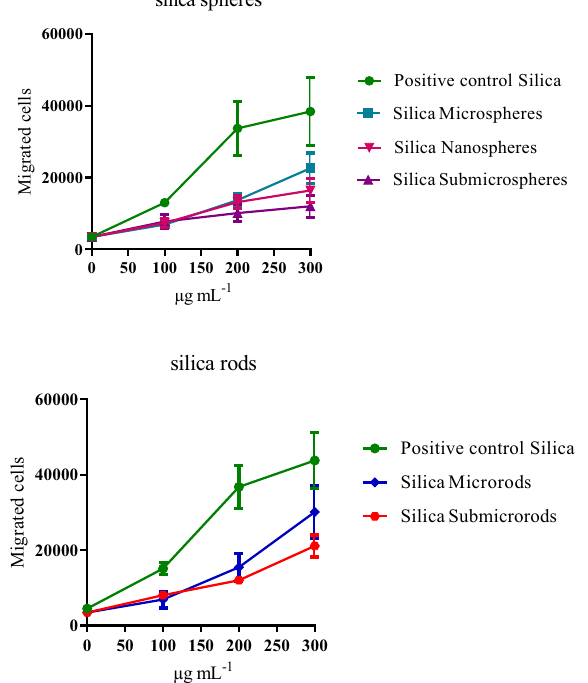
Figure 12. Chemotaxis (migrated cells) of the unexposed dHL-60 cells in response to NR8383 cell supernatants that were obtained from incubations with silica particles between 100 and 300 µg mL −1 . Data are expressed as mean ± SD ( n = 3). Commercial silica nanoparticles served as positive control. Top: Spherical silica particles with control. Bottom: Rod-shaped silica particles with control.